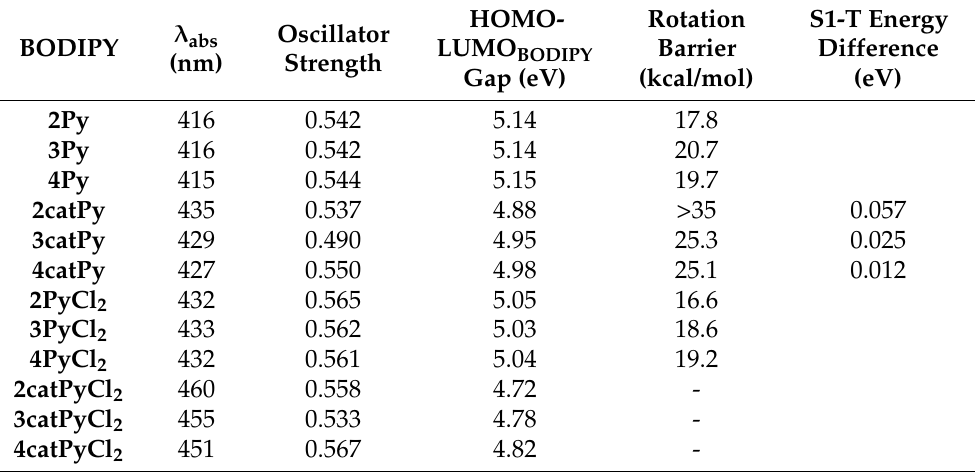
Table 2. Calculated spectroscopic properties, HOMO-LUMO BODIPY gap, rotational barriers of the pyridyl or pyridinium groups with respect to the BODIPY core, and S1 → T energy difference (cam- b3lyp/6-31+G(d,p) in gas phase). The LUMO BODIPY is LUMO for the neutral species but LUMO+1 for the cationic